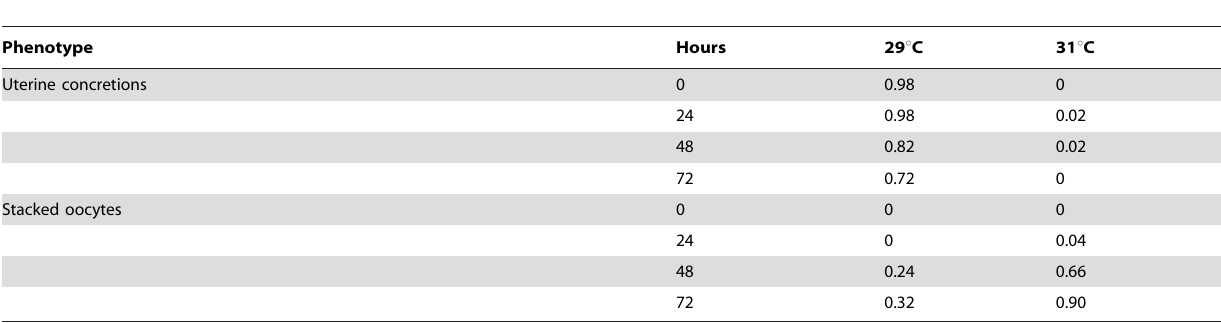
Table 1. Uterine concretions and stacked oocytes in the proximal gonads of worms heat stressed at 29 u C and 31 u C.